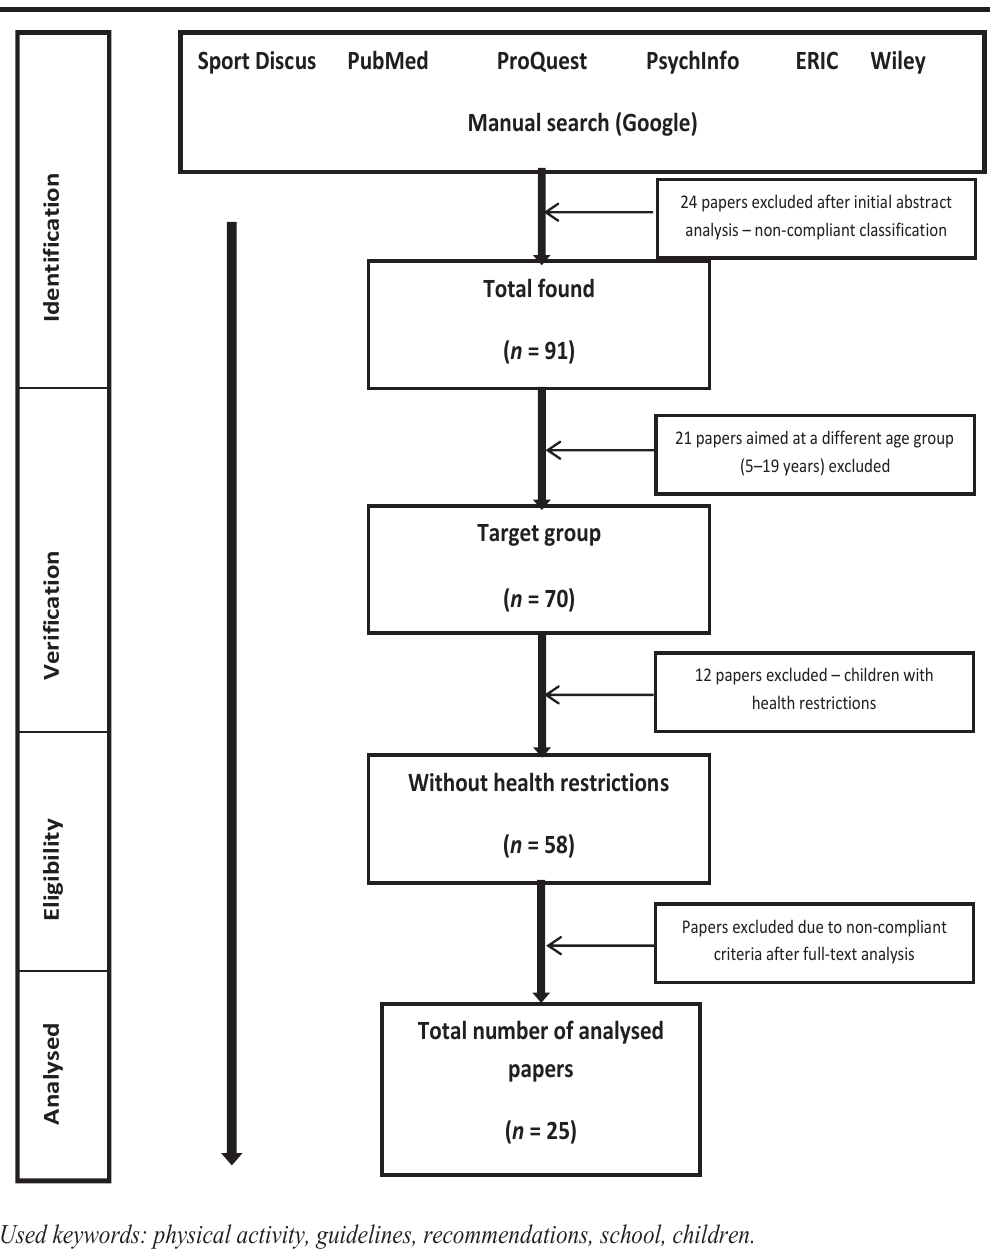
Figure 1. Paper search